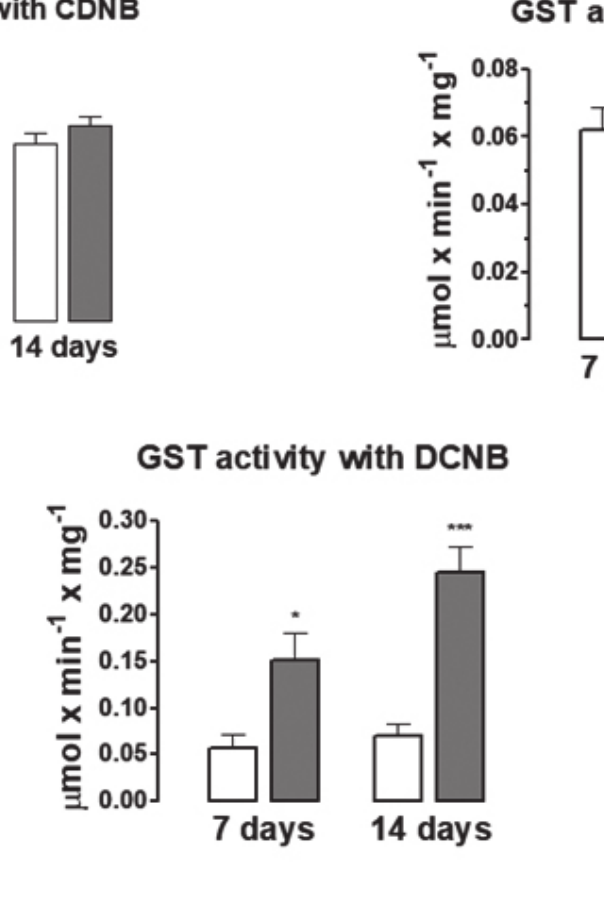
FIGURE 4 | GST specific activities in kidney cytosol from Piaractus mesopotamicus injected with benzo[a]pyrene (15 mg kg -1 ). Assays were carried out with 1-chloro-2,4-dinitrobenzene (CDNB), ethacrynic acid (ETHA) or 2-dichloro-4-nitrobenzene (DCNB) 7 and 14 days after the injection. Bars represent the means ± S.E.M. of determinations from nine fish injected with corn oil (clear) or benzo[a]pyrene (dark grey). Significant different from controls are indicated as *(P < 0.05) and ***(P <